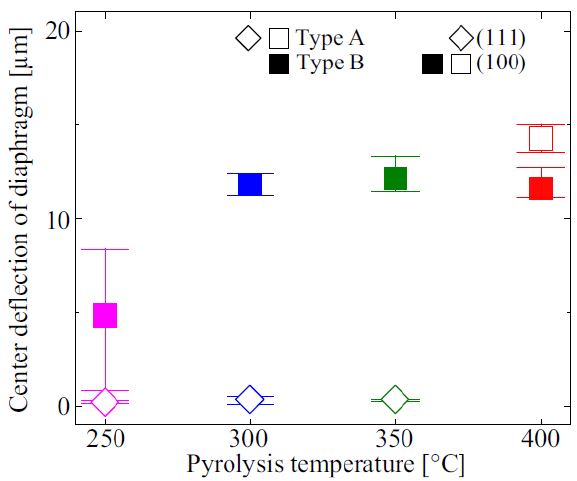
Figure 4. Diaphragm deflection versus PZT pyrolysis temperature.